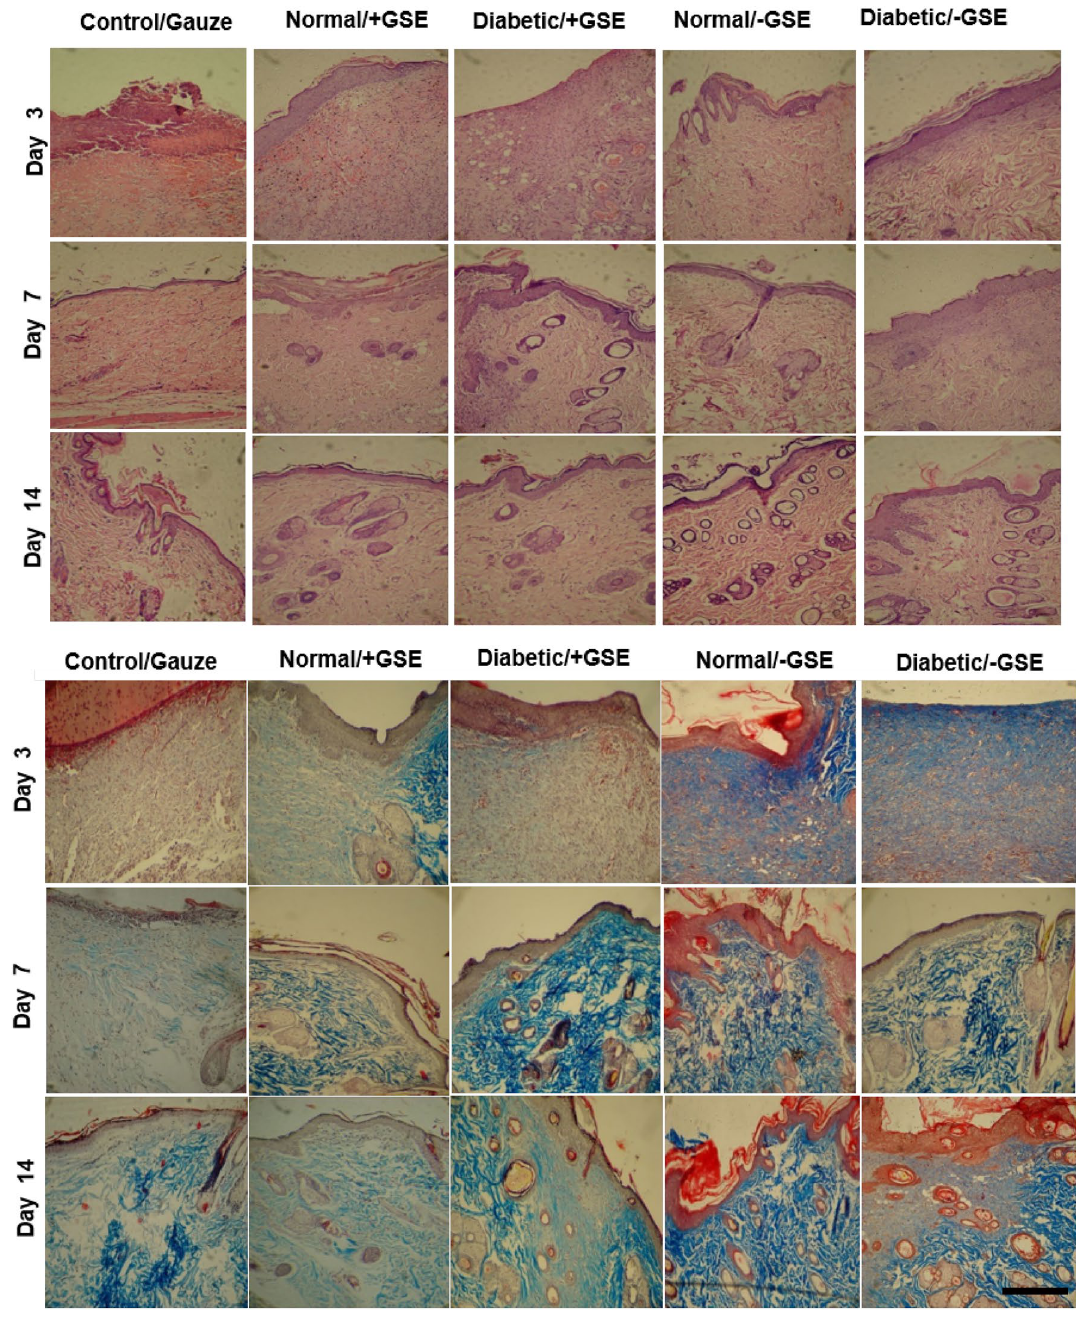
Figure 8. Microscopic evaluation of wound healing. Hematoxylin–eosin staining ( A ) and trichromasson ʼ s staining ( B ). Scale bar represents 200